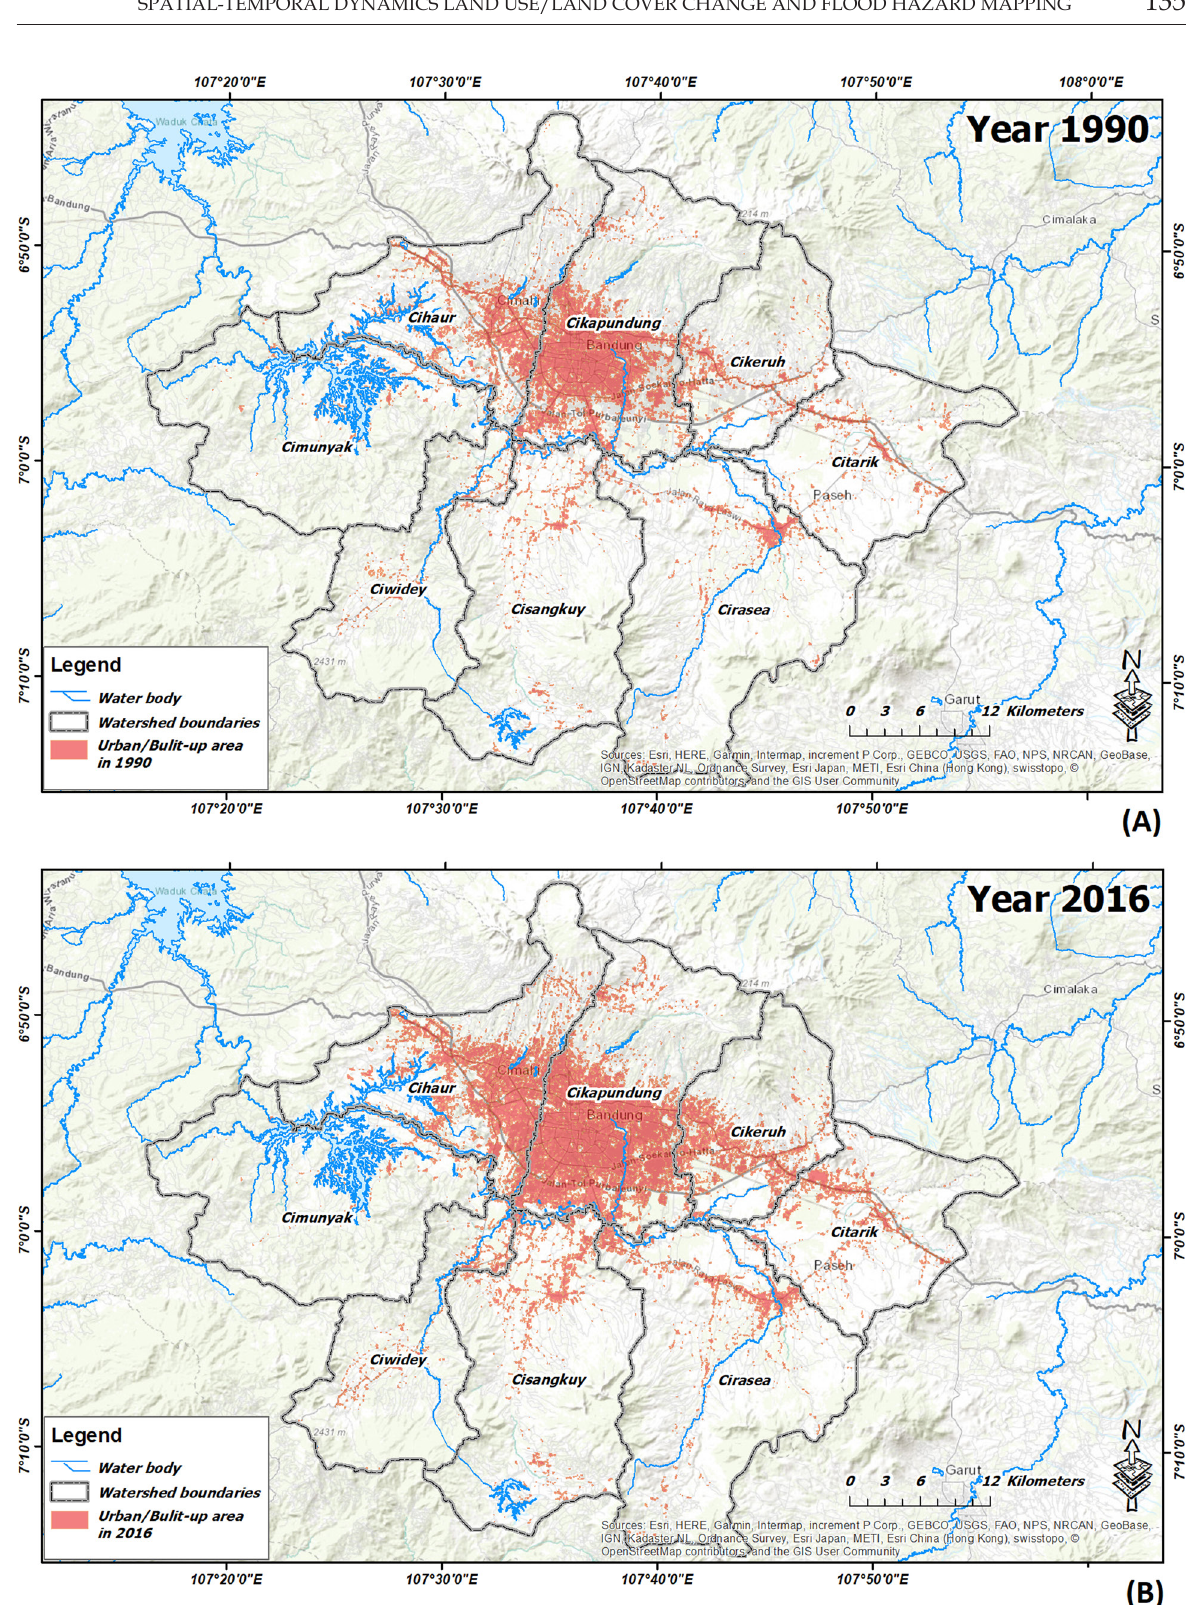
Fig. 6. Distribution of urban/built-up area expansion in the eight sub-watersheds in the study area in 1990 (A) and 2016